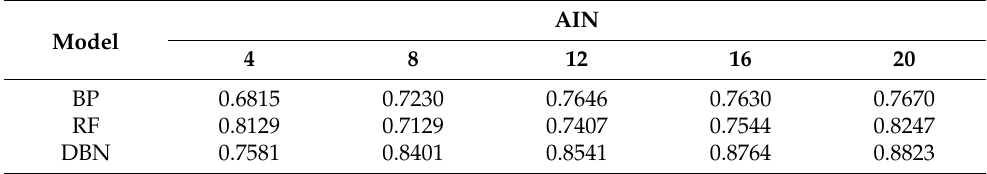
Table 6. AUC values of different data-based models and different AIN values.